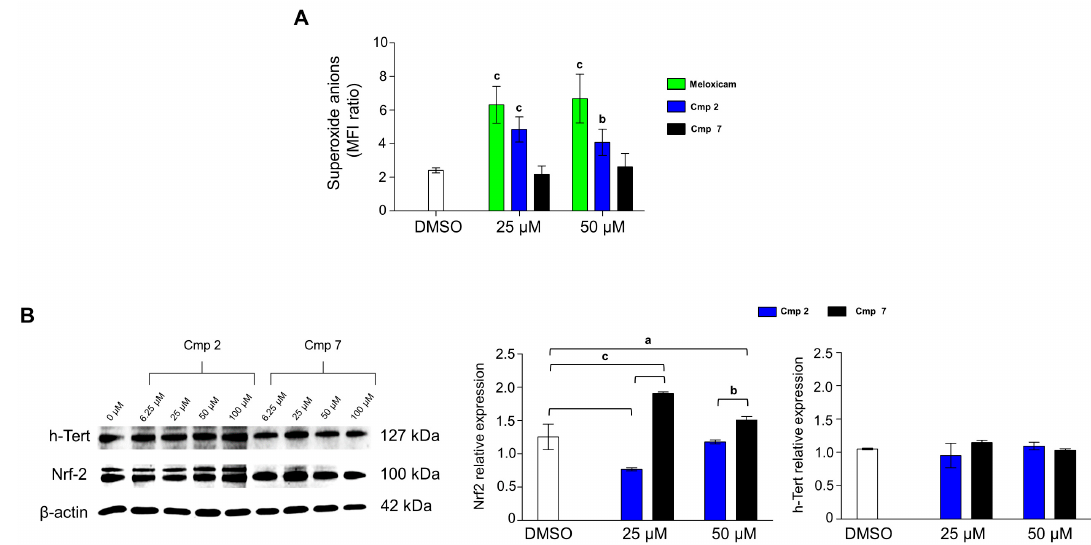
Figure 7. Generation of superoxide anions and Nrf2 and h-Tert expression levels in tendon-derived cells pre-incubated with hydrogen peroxide (H 2 O 2 ) in the presence of Meloxicam, Cmp 2 and Cmp 7 . Data are reported as means ± standard deviations of independent experiments with the three donors pooled (n = 9). ( A ) The bar graph shows mean fluorescence intensity (MFI) ratios related to the emission in the FL-2 channel which are proportional to the generation of superoxide anions in tenocytes pre-incubated with H 2 O 2 100 µ M for 3 h and exposed as indicated for 24 h. Values are the ratios of the MFI generated from each sample on the unstained control (negative). ( B ) Western blot analysis of Nrf2 and h-Tert protein expression in tenocytes in the same indicated experimental conditions of ( A ). β -actin is used as loading control. Bar graphs display densitometric values expressed as mean D.O.I normalized on the ones of the loading control. a = p < 0.01; b = p < 0.001; c = p < 0.0001 between samples and DMSO alone. DMSO = cultures pre-incubated with H 2 O 2 and treated with DMSO